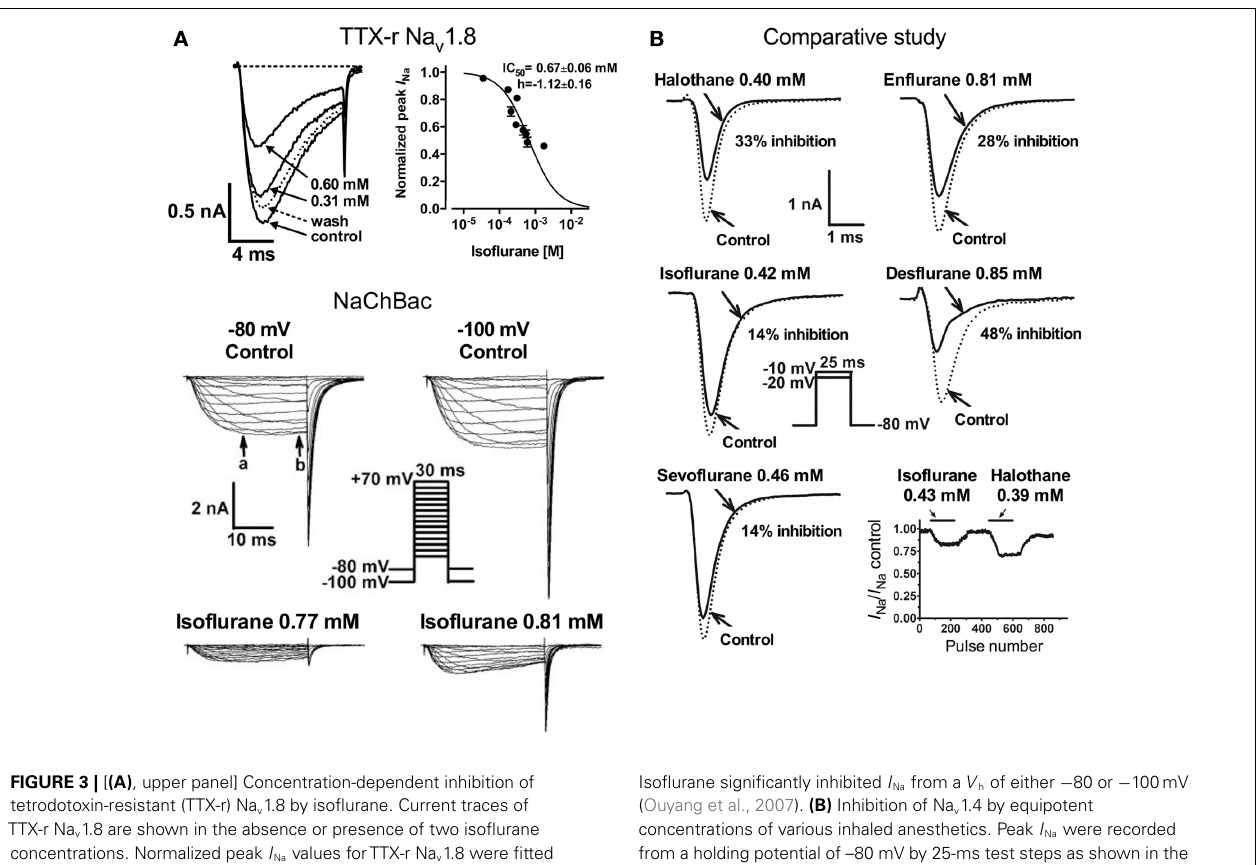
Isoflurane significantly inhibited I Na from a V h of either − 80 or − 100mV (Ouyang et al., 2007). (B) Inhibition of Na v 1.4 by equipotent concentrations of various inhaled anesthetics. Peak I Na were recorded from a holding potential of –80 mV by 25-ms test steps as shown in the inset .The effects of clinically equipotent concentrations of halothane, isoflurane, sevoflurane, enflurane, and desflurane are shown in these representative traces. Desflurane had the greatest effect of peak I Na